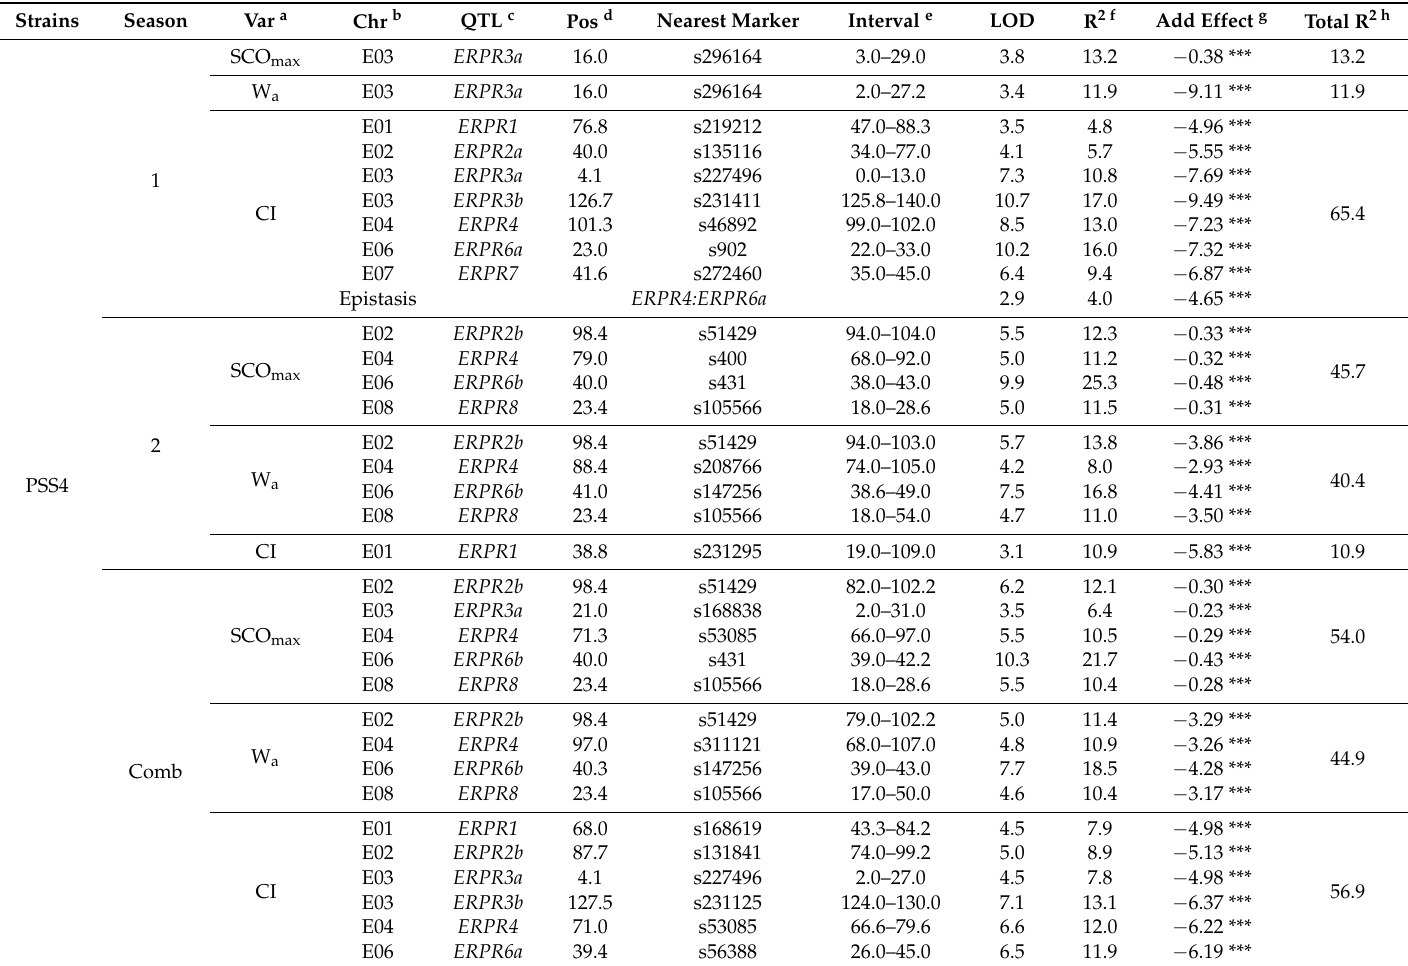
Table 3. QTLs of resistance to PSS4 and R3598 strains, detected by multiple QTL mapping (stepwise model) for the EG203 × MM738 DH population, on individual seasons and across the seasons